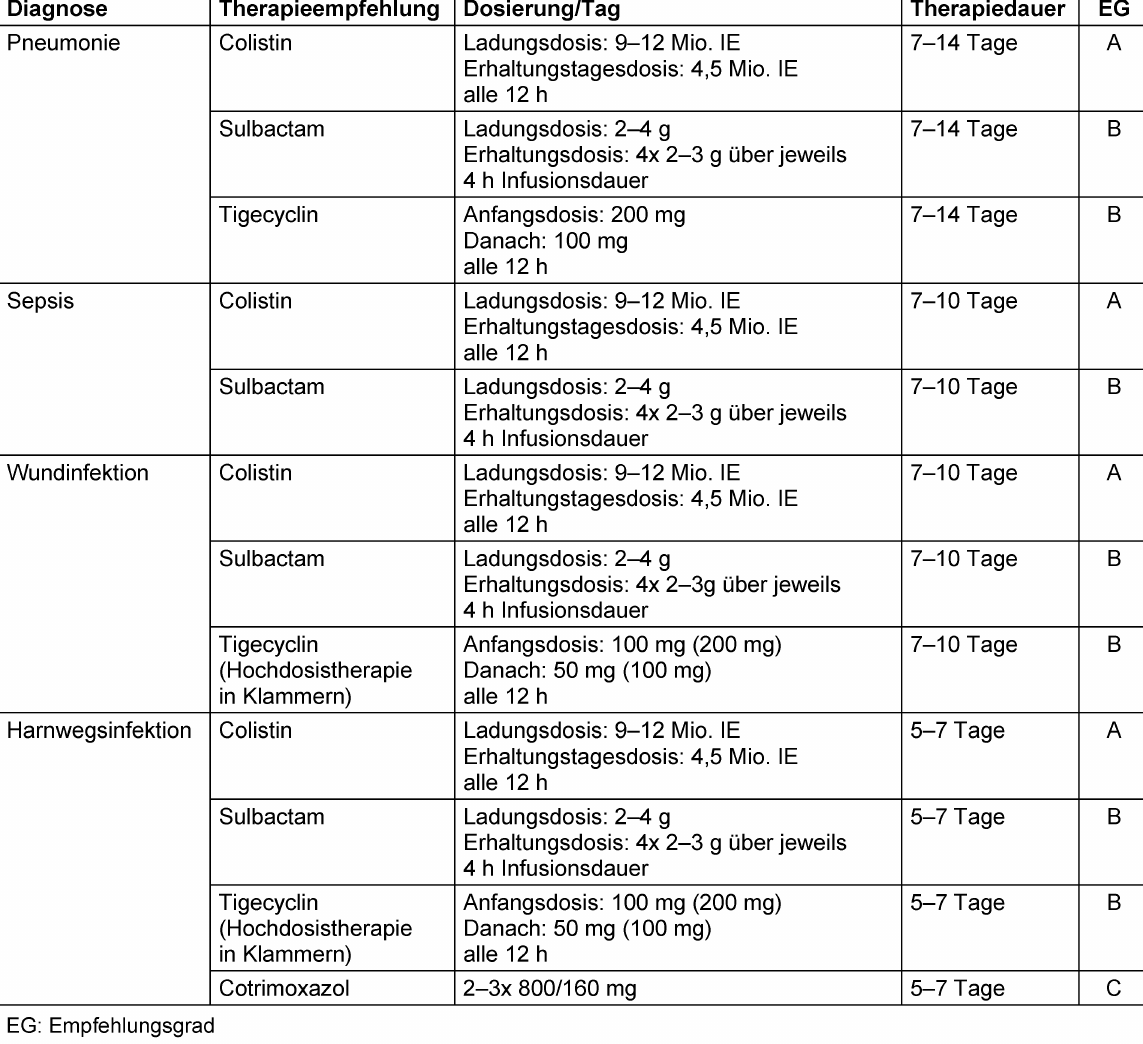
Tabelle 4 und Tabelle 5 fassen die Vorschläge für